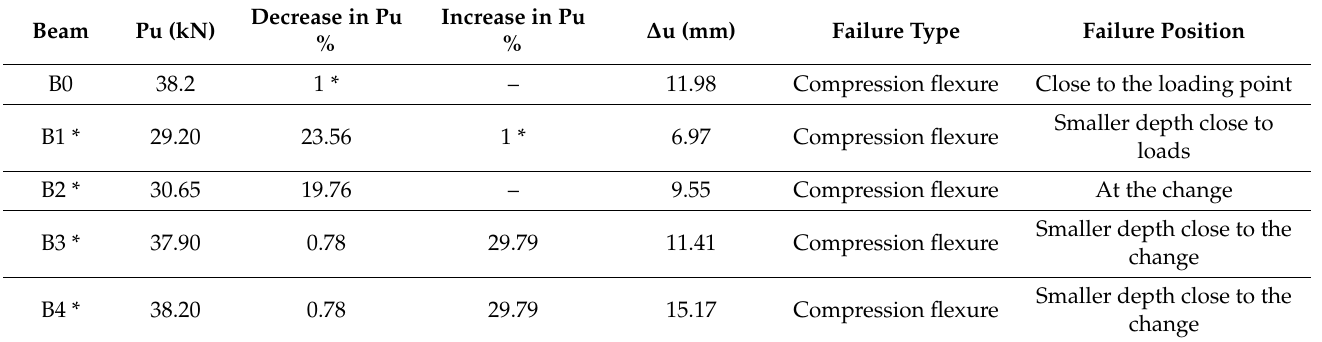
Table 3. Results of the tested beams of group